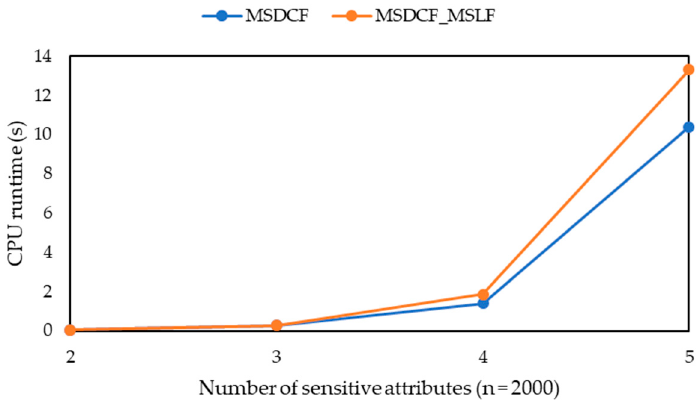
Figure 13. The CPU runtime of MSDCF and MSDCF-MSLF with different sensitive attribute numbers ( n = 2000).